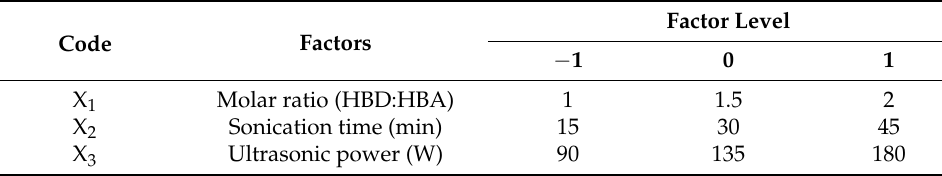
Table 1. Independent variables and their levels. Code